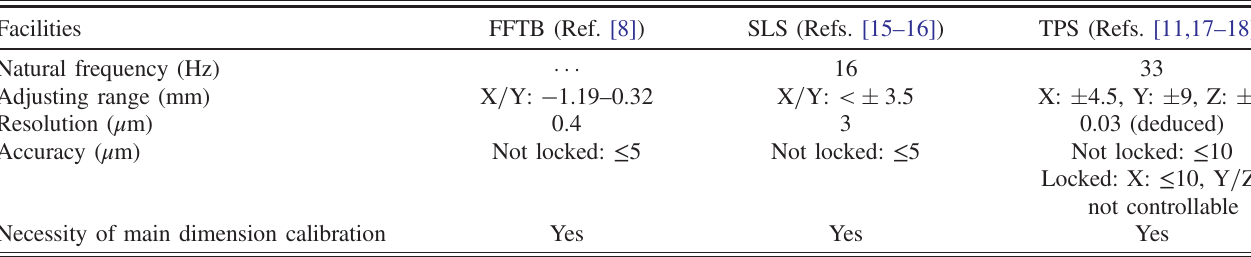
TABLE II. Performance of existing autotuning magnet girders.